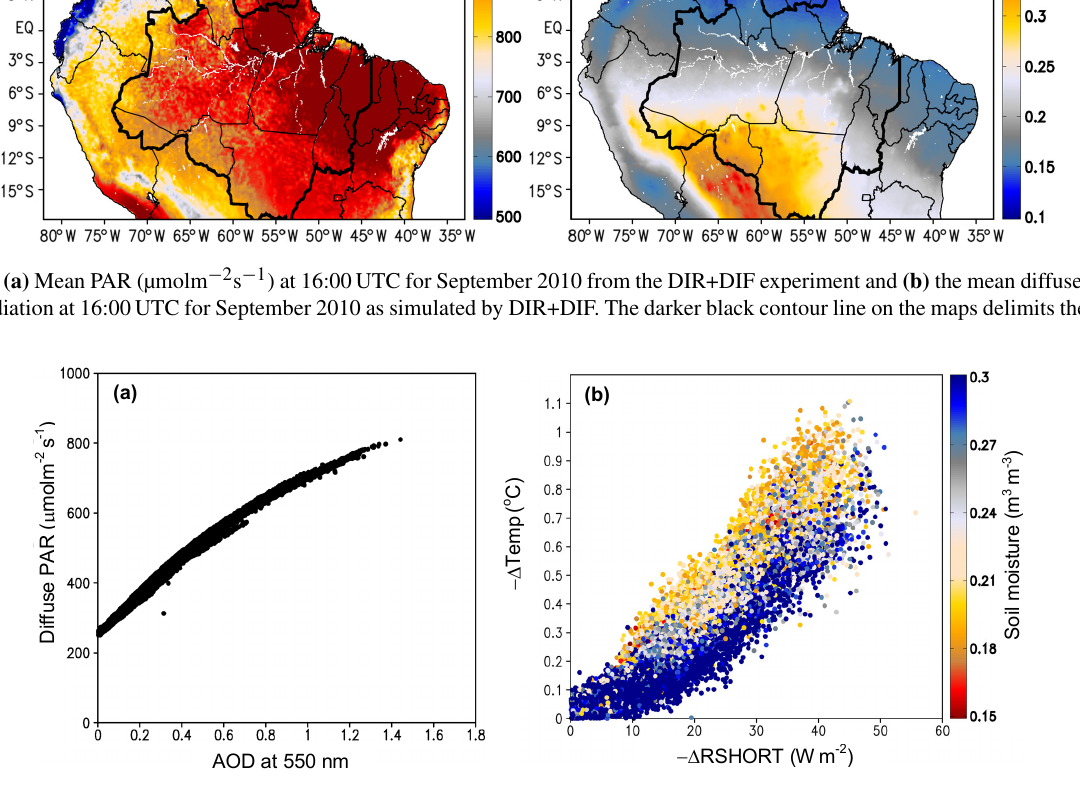
Figure 12. (a) The diffuse PAR radiance (µmolm − 2 s − 1 ) versus AOD at 550nm as simulated in the DIR+DIF experiment at 16:00UTC during September 2010 (temporal) in the LBAR (spatial). (b) The decrease in 2m temperature versus the decrease in downwelling shortwave irradiance (Wm − 2 ) as simulated in the AER-DIR and NO-AER experiments at 16:00UTC during September 2010 in the LBAR. The color scale refers to soil moisture (m 3 m − 3 ) at